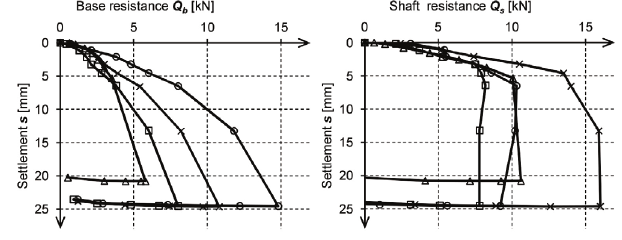
Fig. 8. Characteristics of shaft and base resistances of selected SDP piles from the group, compared with the same resistances of a single SDP pile